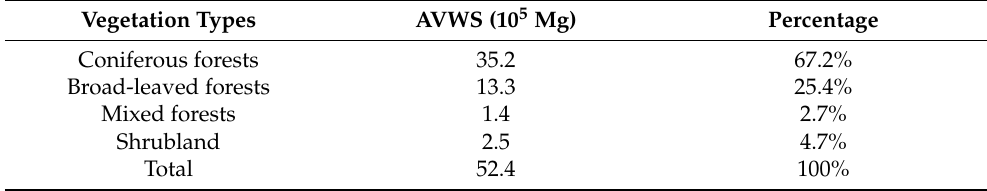
Table 2. Statistics of the aboveground vegetation water storage (AVWS) in the study area.